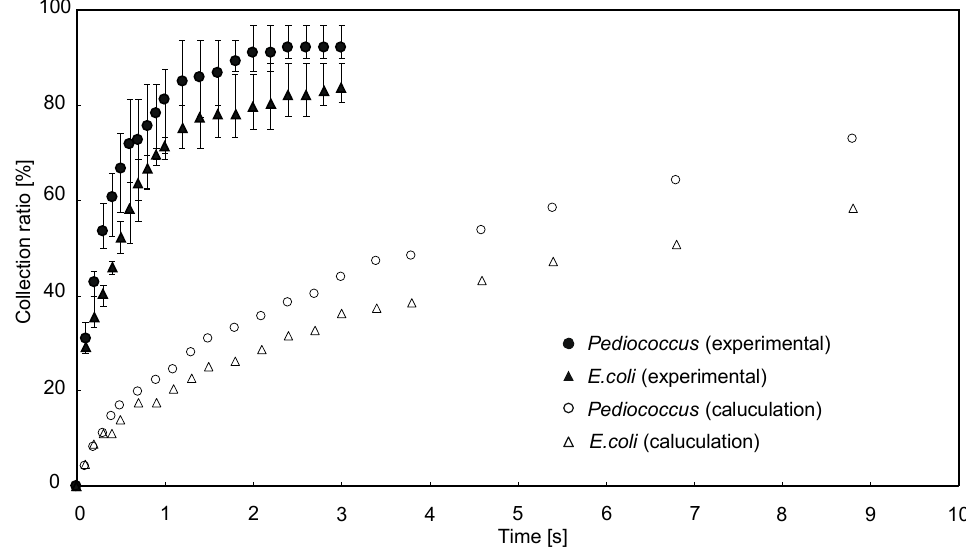
Figure 7. Time variation in the number of captured bacteria: measurements were performed at least three times to confirm reproducibility. The trapping amount saturates at a value of more than 80% in about 2 s.